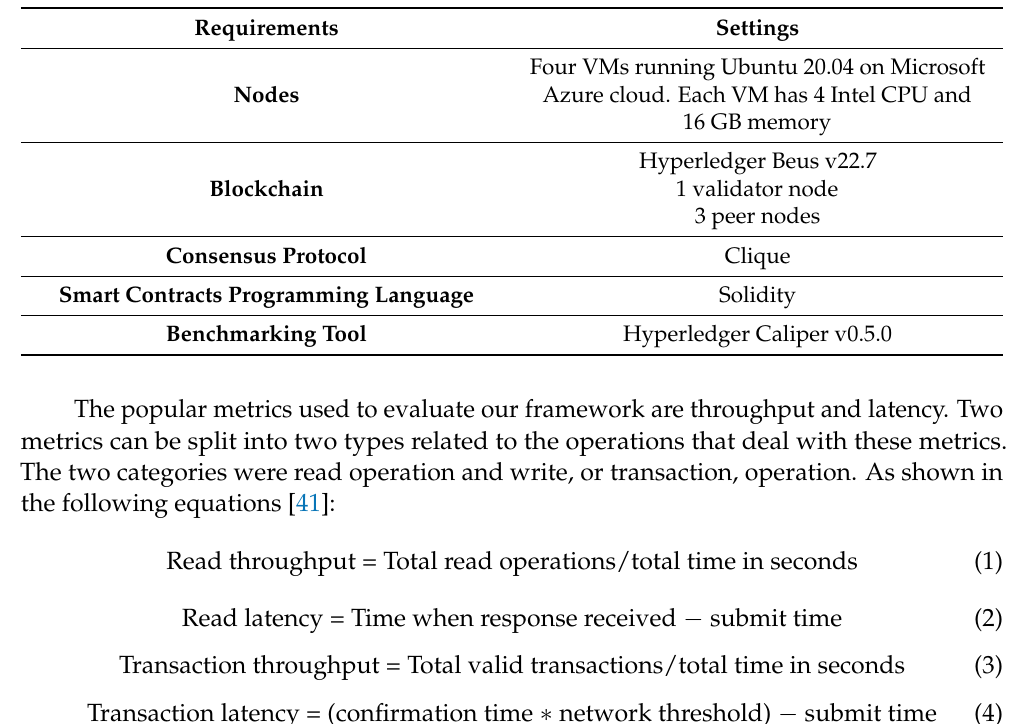
Table 3. Testing environment for